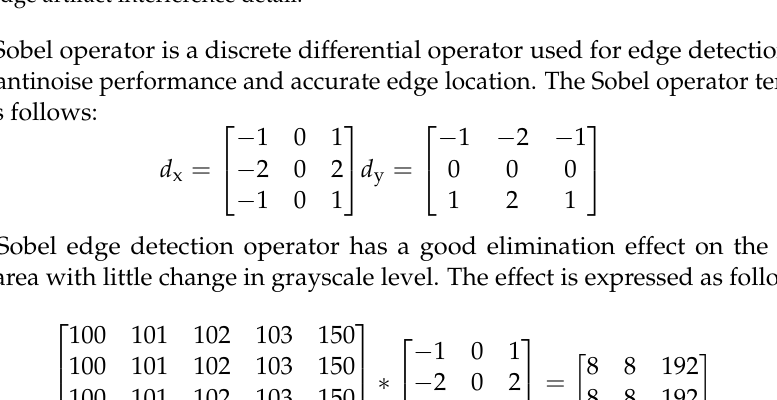
Figure 8. Edge artifact interference detail.